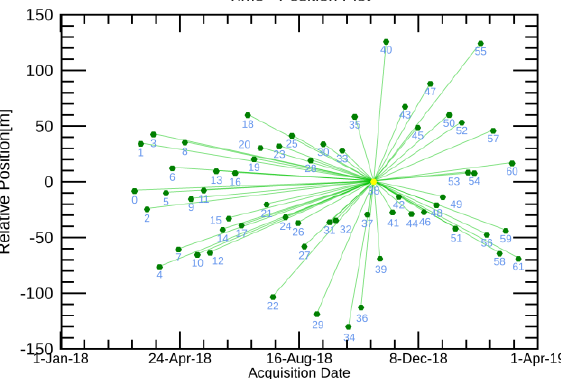
Figure 4. Time and baselines relationship between master (yellow) and slaves (green)